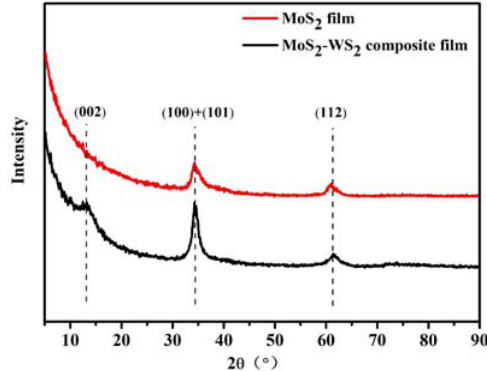
Figure 4. XRD di ff raction patterns of pure MoS 2 and MoS 2 –WS 2 composite film. Figure 4. XRD diffraction patterns of pure MoS 2 and MoS 2 –WS 2 composite film.